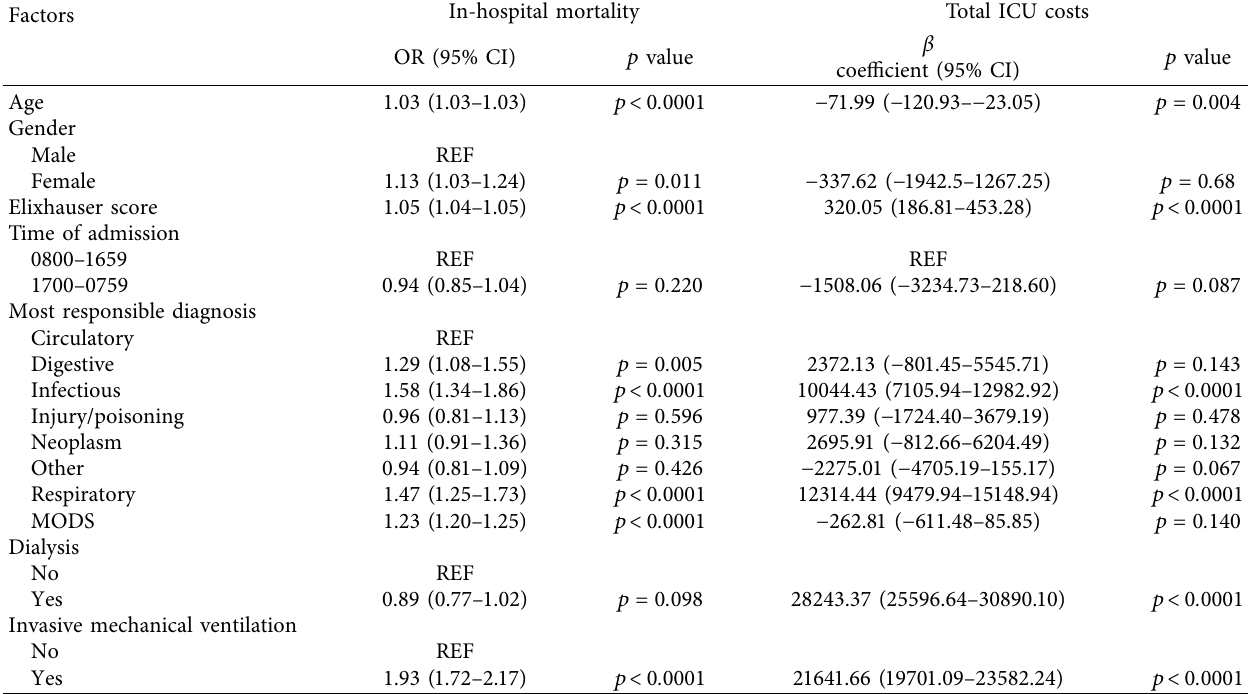
Table 3: Multiple regression analysis between time of admission and mortality and total ICU costs.